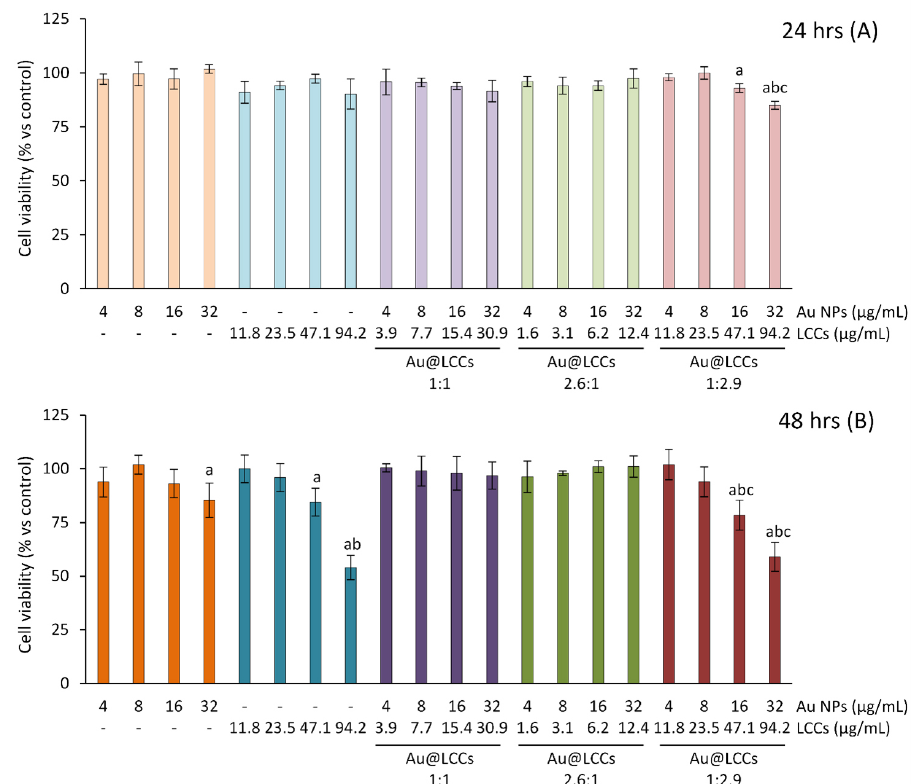
Figure 8. NIH/3T3 cell viability. NIH/3T3 fibroblasts were exposed to Au NPs (range: 4–32 µg/mL), LCCs (range: 11.8–94.2 µg/mL) or Au@LCCs dispersions (range: 4–32 µg/mL expressed as Au) for